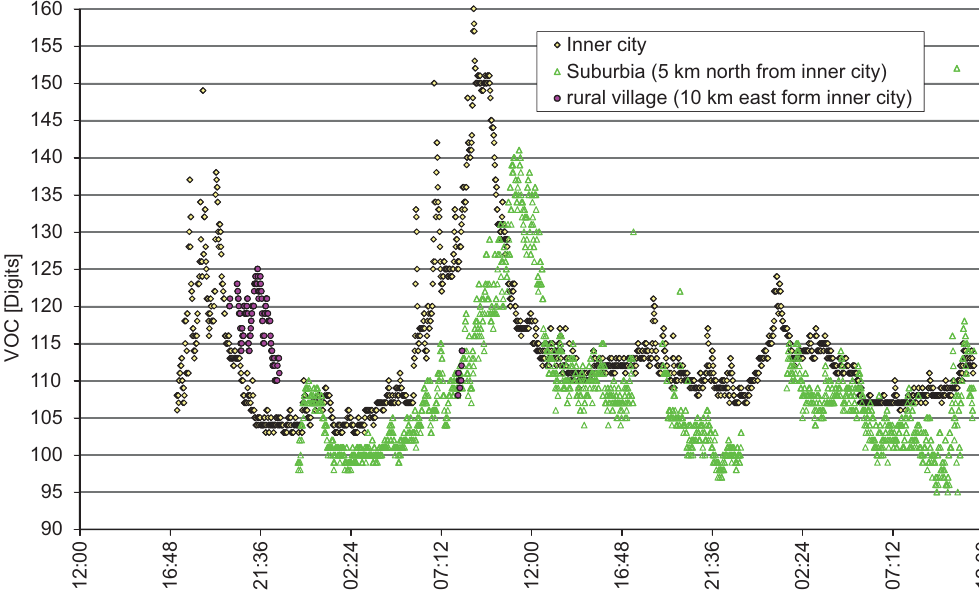
Figure 5. Outside VOC measurements over 2 days at three different locations